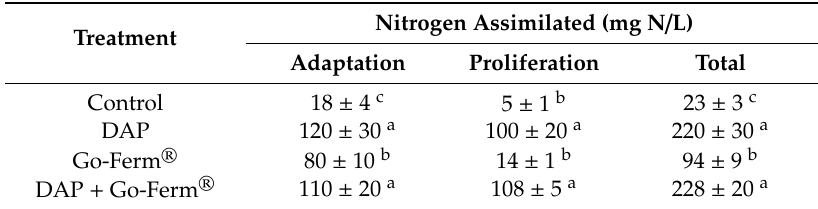
Table 4. Quantity of total nitrogen assimilated during adaptation, proliferation and the entire yeast acclimatization process. Treatments were replicated ( n = 4) and are represented as the mean ± standard deviation. Lower case letters indicate statistical di ff erences in nitrogen consumption between treatments determined by ANOVA with mean separation by Fisher’s Protected